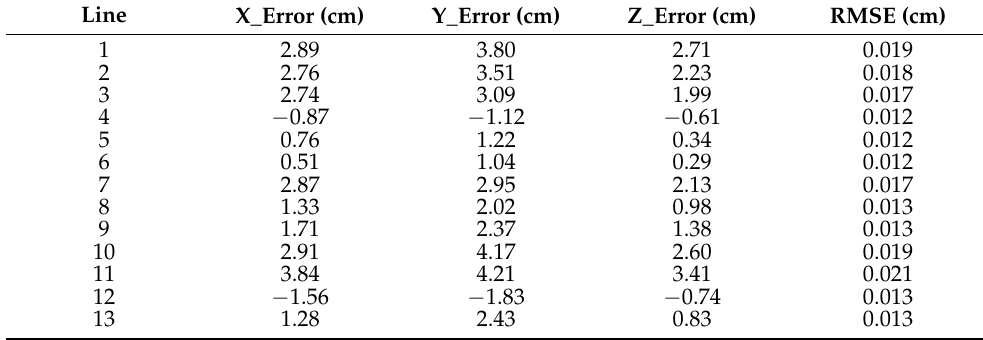
Table 4. Evaluation of connection finding and